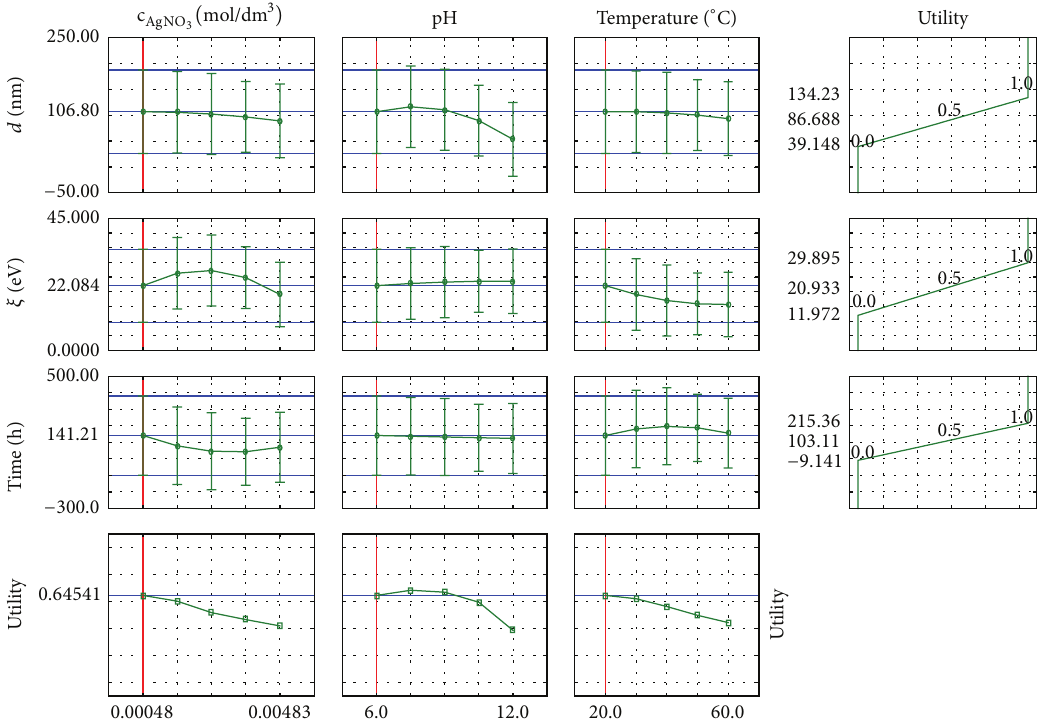
Figure 8: Profile of response surface regression predicted for nanosilver suspensions obtained based on dog rose extract.